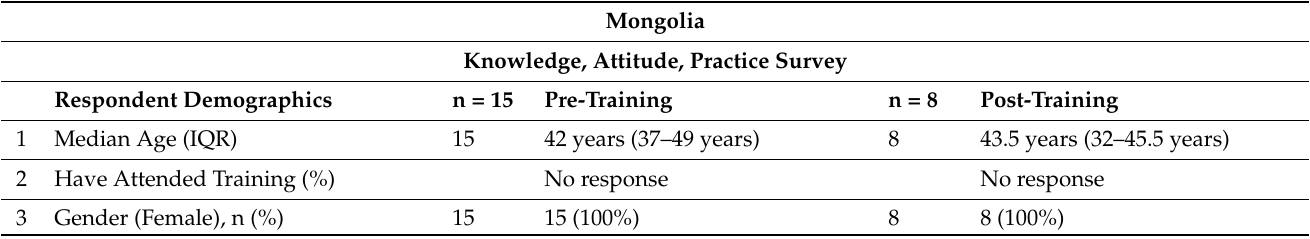
Table A1. Prevalence of Desired Answers of Knowledge, Attitude and Practice Surveys (KAPS) from Pre-training and Post-training in Mongolia. Knowledge Questions are Yellow, Attitude Questions Red and Practice Questions